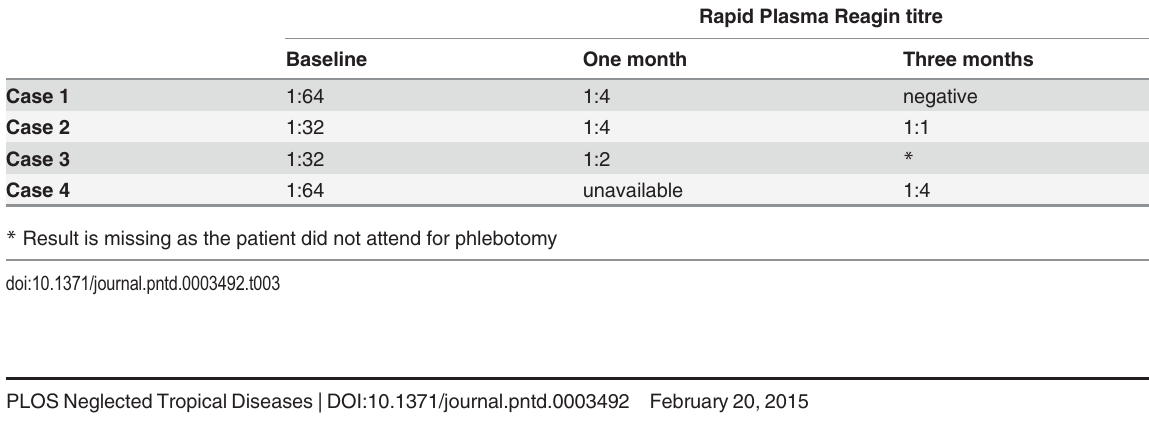
Table 3. Serological follow-up of